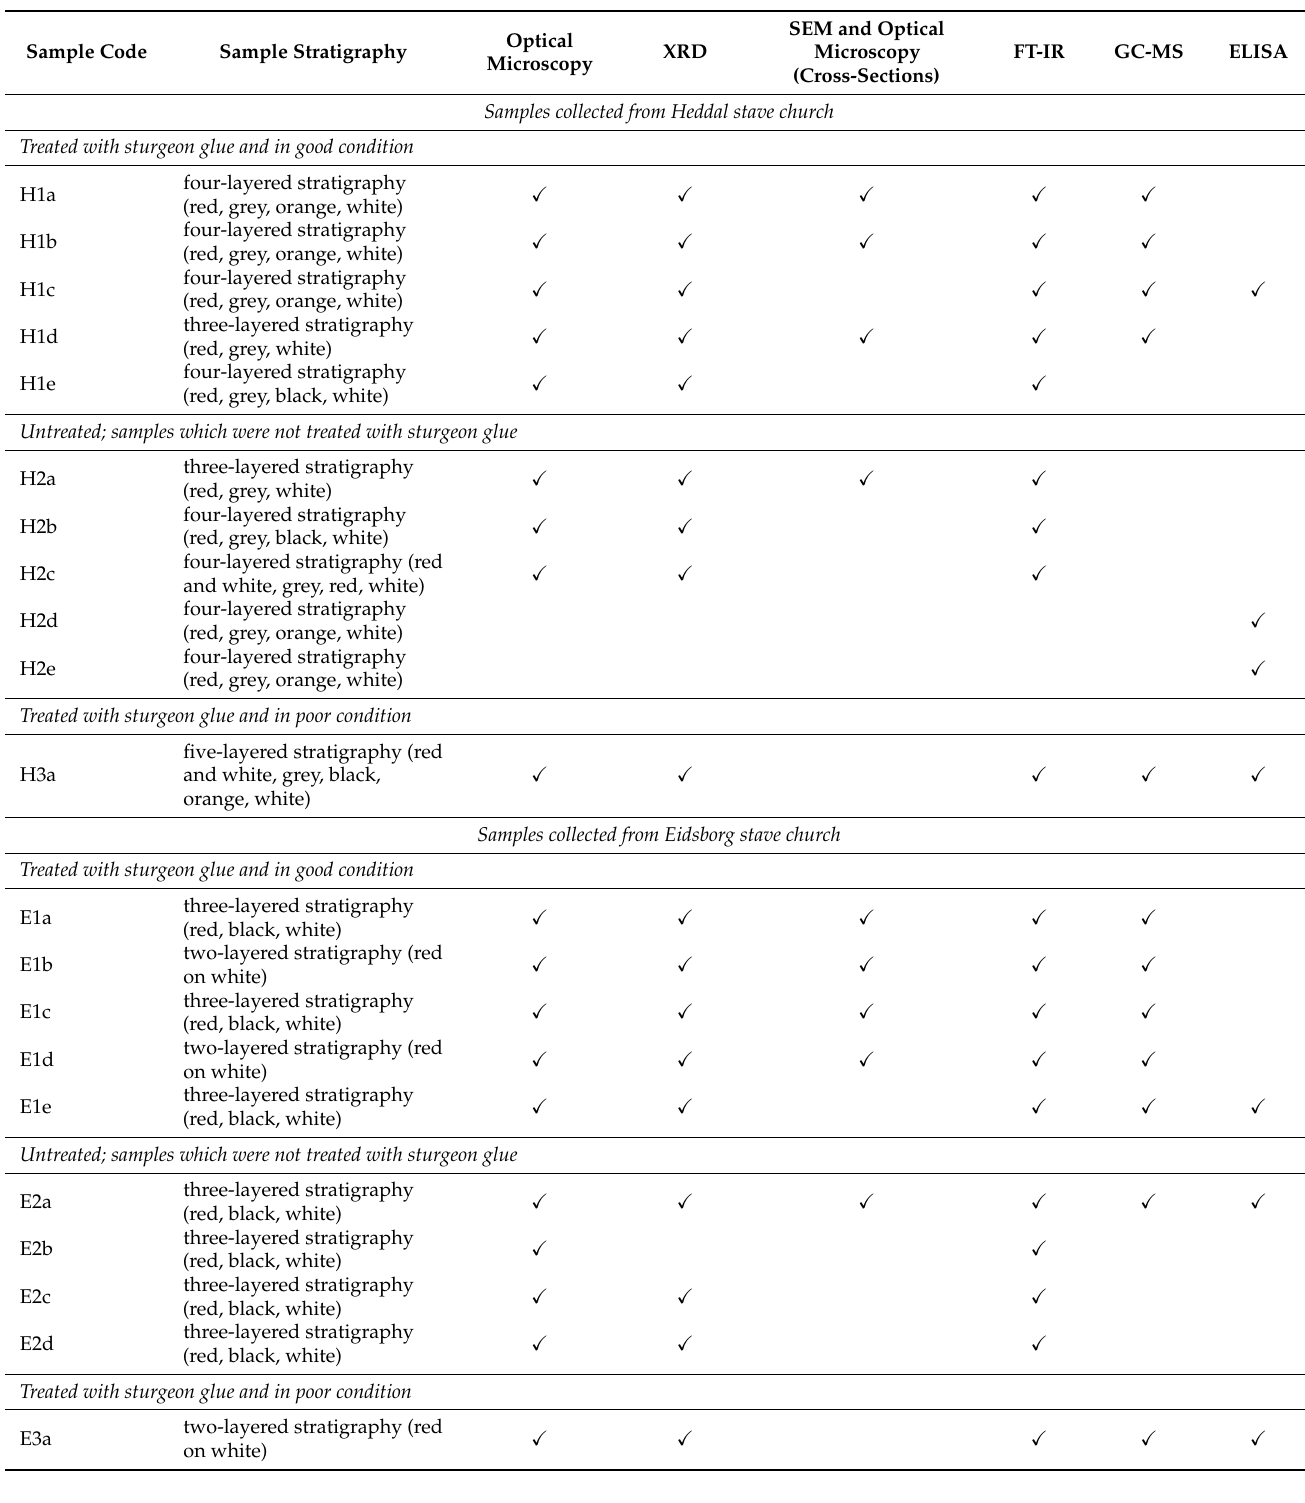
Table 2. Sample details: summary of sample description and techniques used during this case study. Samples correspond to those displayed in Figure